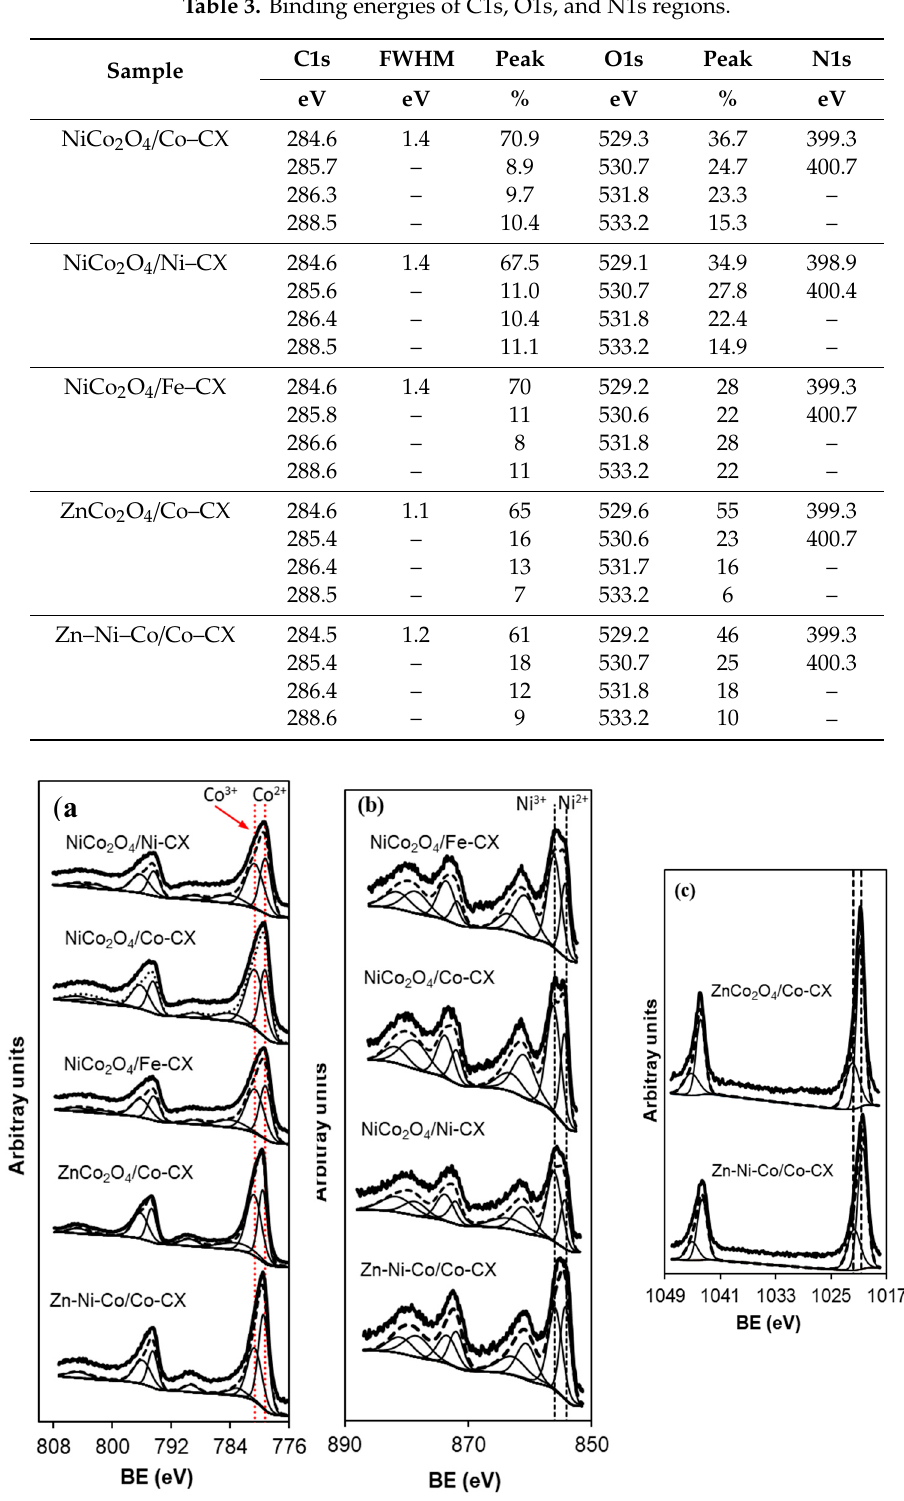
Figure 5. Deconvolution of XP spectra for ( a ) Co2p, ( b ) Ni2p, and ( c ) Zn2p regions.